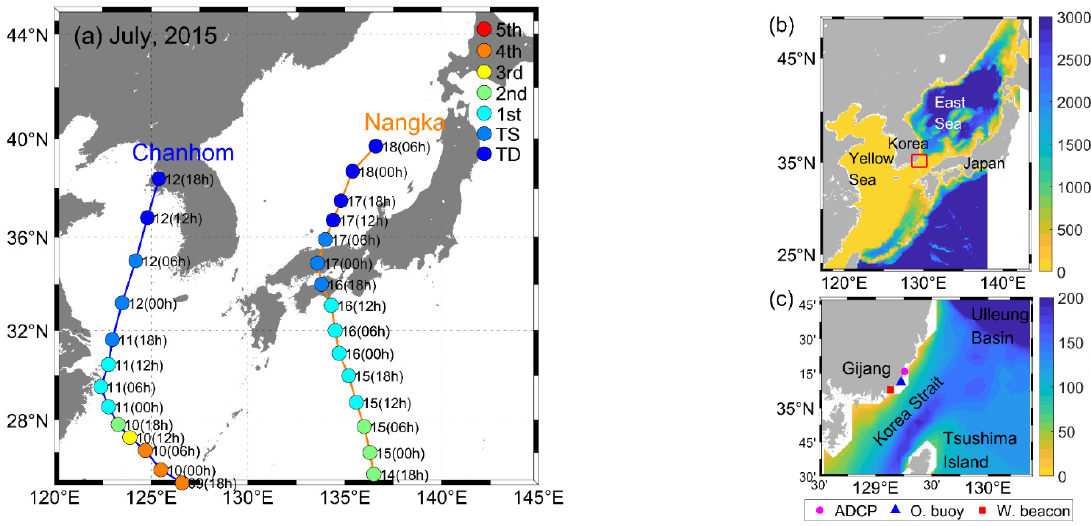
Figure 1. ( a ) Track of the two typhoons, Chanhom and Nangka, around the Korean Peninsula in July 2015. The colors of the circle denote the scale of the typhoon based on the Saffir–Simpson hurricane wind scale, as shown in the top right corner; bathymetry of ( b ) the entire domain of the high-resolution numerical ocean model (DR_M) and ( c ) the southeast coast of Korea. The red square in ( b ) indicates the study area exhibited in ( c ). The magenta, blue, and red markers in ( c ) denote the sites of the Acoustic Doppler Current Profiler (ADCP) mooring, ocean buoy, and wind-measuring light